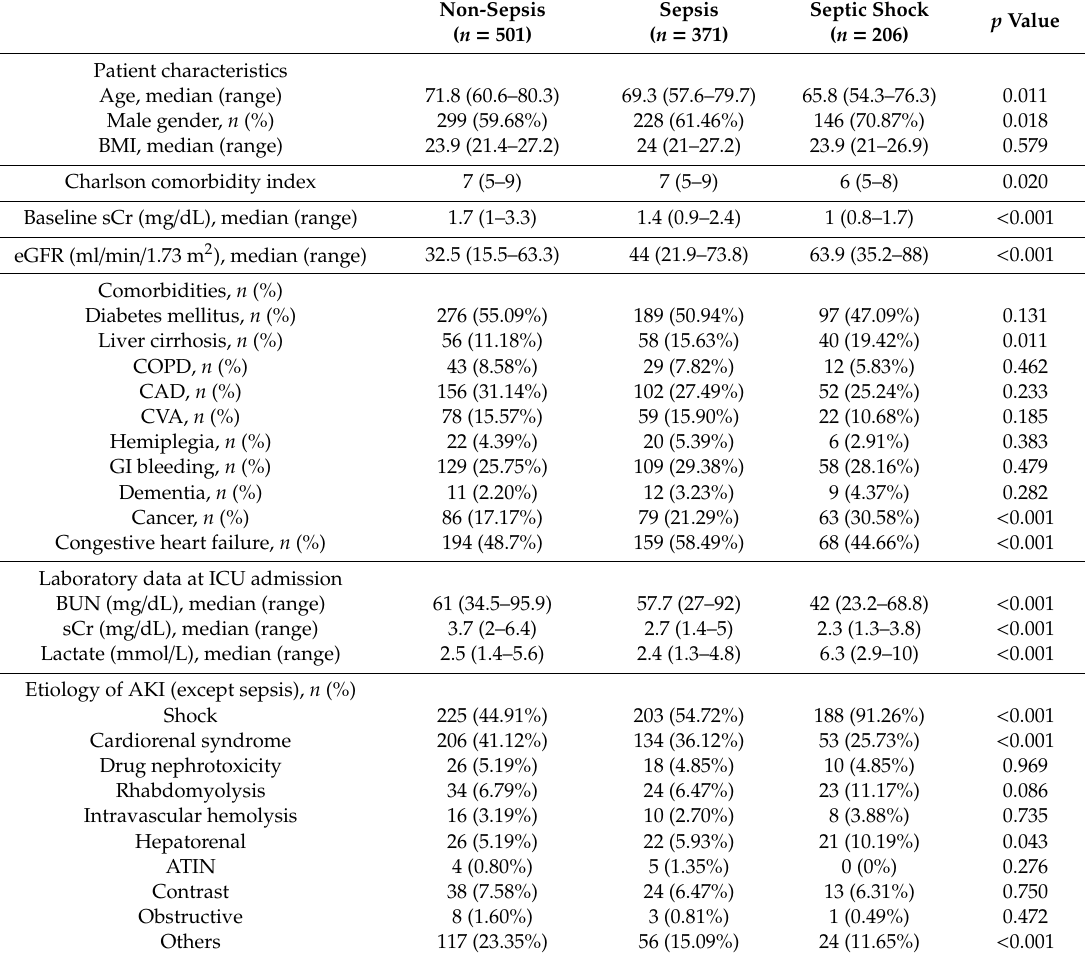
Table 1. Clinical characteristics of patients with and without